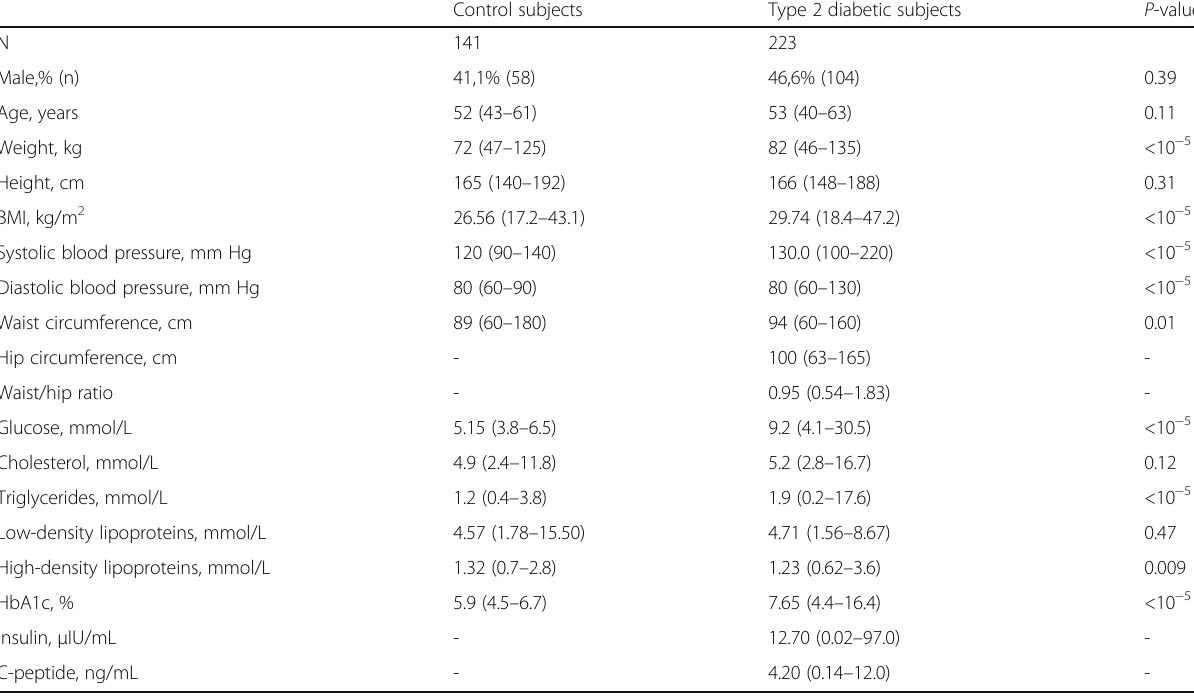
Table 3 Clinical and biochemical characteristics of the Kazakh study cohorts matched for age Control